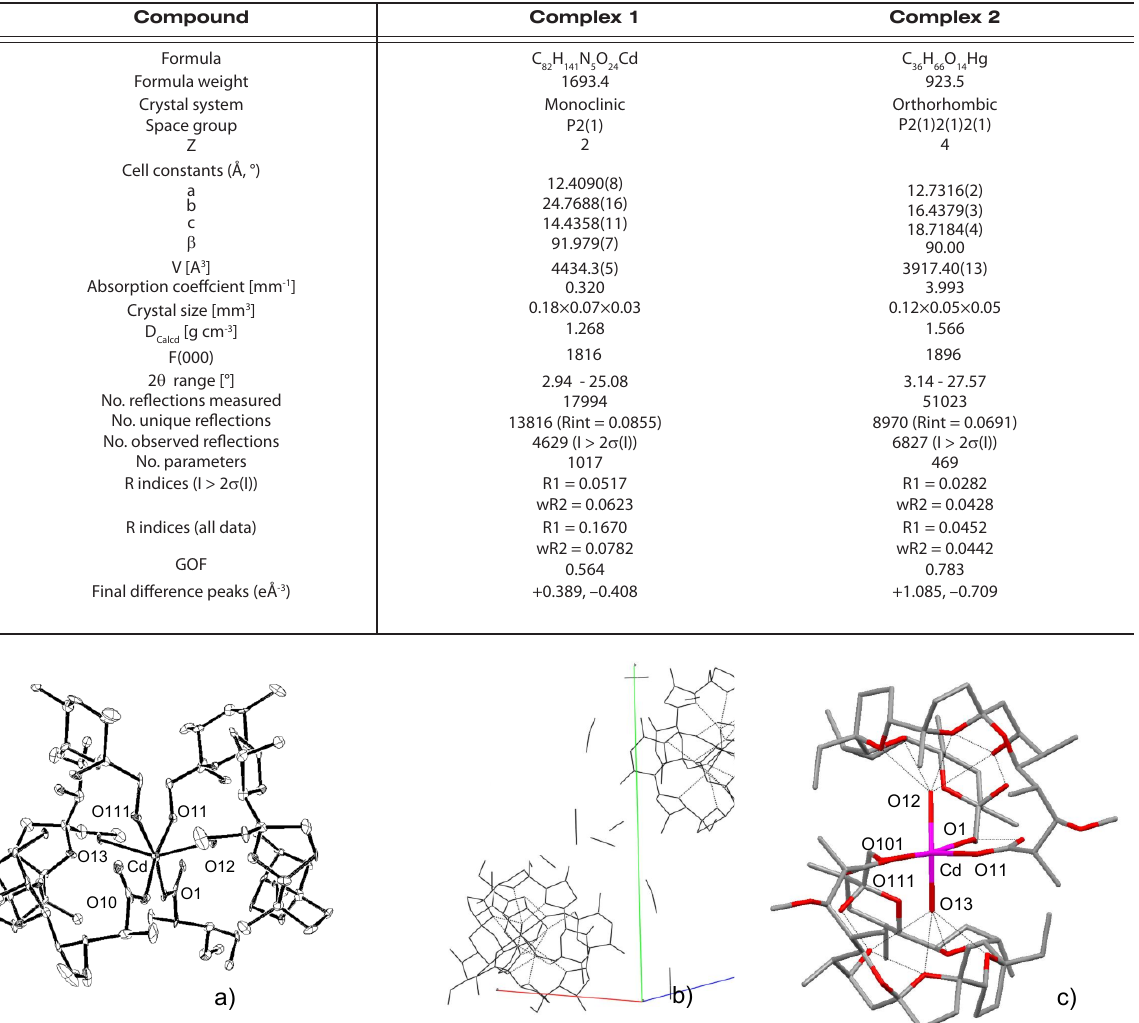
Table 1. Crystal data and structure refinement for compounds 1 and 2